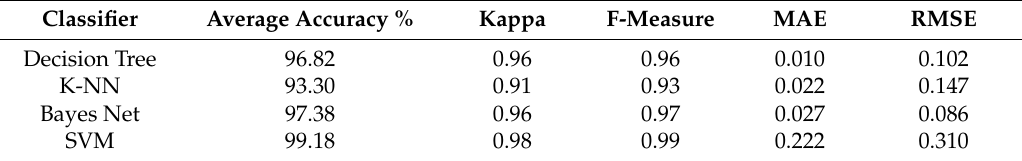
Table 6. Average performance metrics of the selected classifiers for activity recognition.